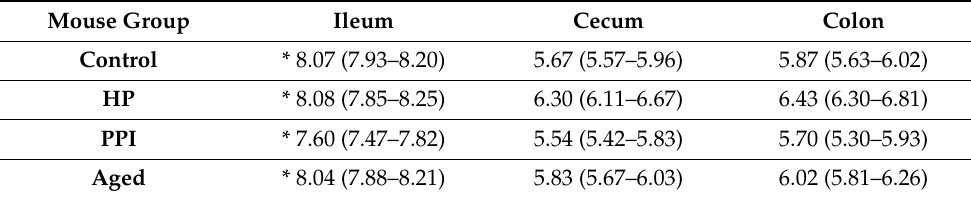
Table 1. pH values in different parts of mouse guts with different treatments, shown as the median (minimum value − maximum value). Since purified water (approximately pH 7) was added to contents, the real pH is higher for alkaline pH values and lower for acidic pH values. In all groups tested, pH values were significantly different ( p < 0.05) between ileum vs. cecum and ileum vs. colon but not cecum vs. colon.